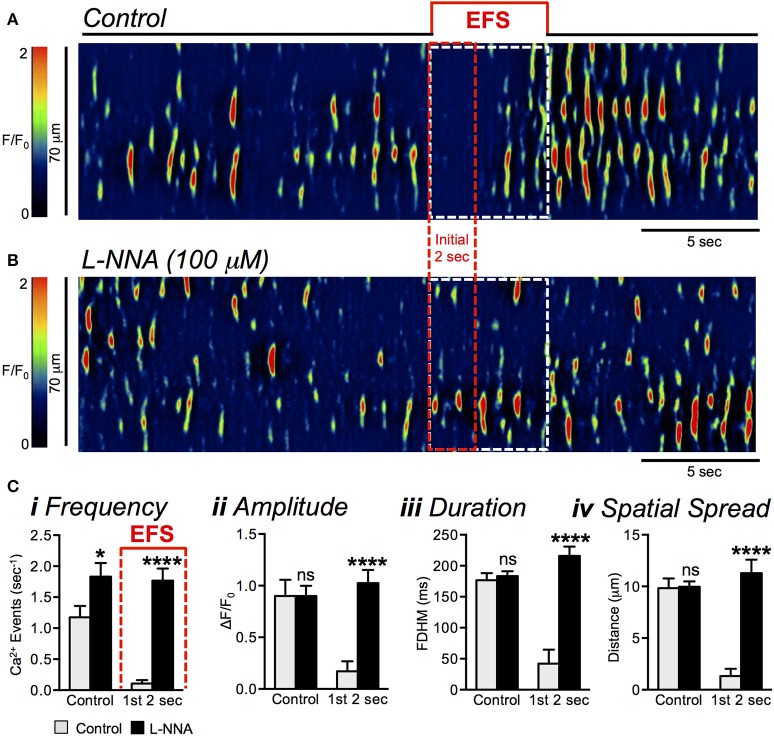
Effects of L-NNA on EFS-evoked inhibition of Ca2+ transients. (A,B) Representative ST maps of ICC-DMP showing inhibition of Ca2+ transients initially during sustained EFS (A; EFS at 10 Hz for 5 s; indicated by the solid red line and dotted white box in ST maps) and the relief of EFS evoked inhibition on Ca2+ transients in the presence of L-NNA (100 μM; B). The dotted red box indicates the initial 2 s of sustained EFS. (C) Summary data showing the inhibitory effects of L-NNA (100 μM) on Ca2+ transient frequency (i), amplitude (ii), duration (iii), and spatial spread (iv) in ICC-DMP during control conditions (pre-EFS), and in the 1st 2 s of EFS (n = 5, c = 15). ns = P > 0.05, *P < 0.05, ****P < 0.0001.